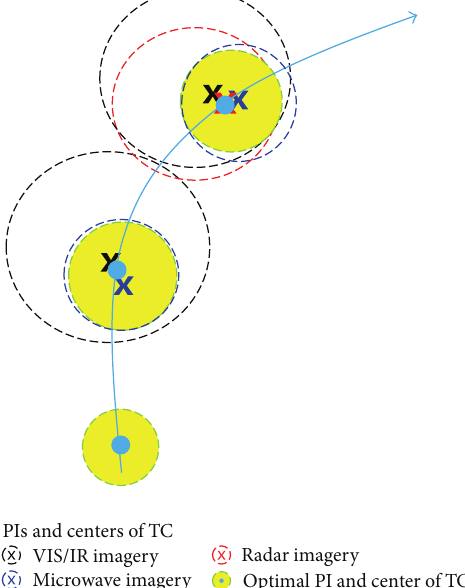
Figure 3: Conceptual diagram of the optimization method from various potential intervals (PIs). “X” represents the estimated centers of the tropical cyclone from VIS/IR (black), microwave (blue), and radar (red) imagery. The optimal PI is